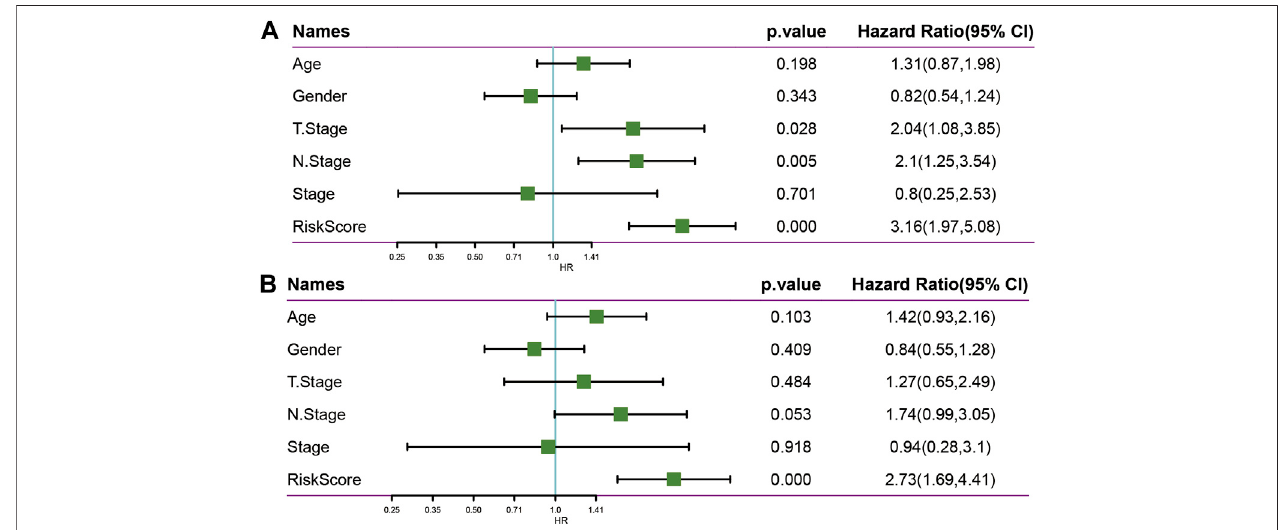
FIGURE 10 | (A) Univariate analysis in TCGA data set; (B) Multivariate analysis in TCGA data